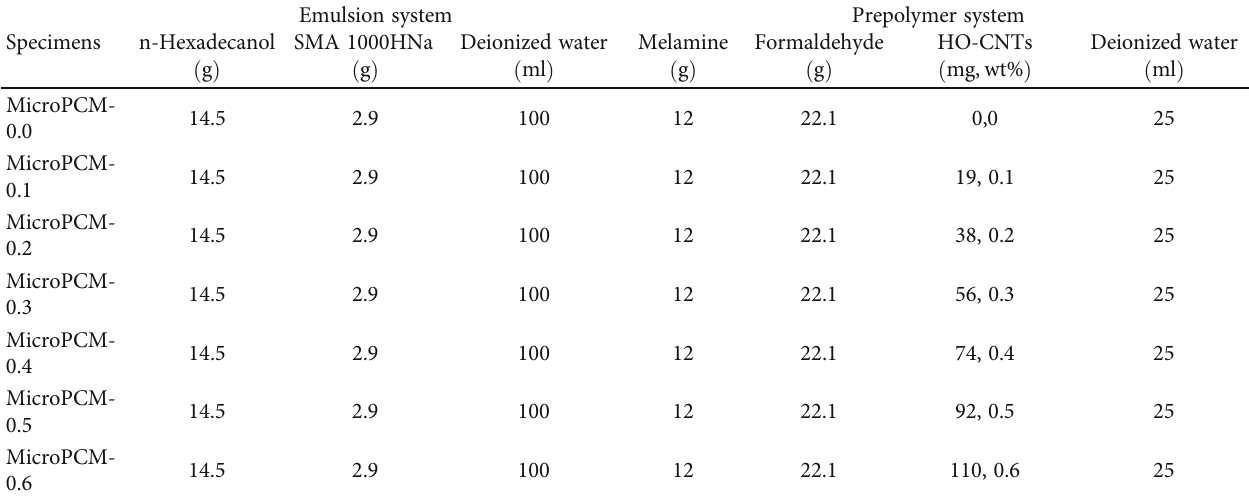
Table 1: The experimental protocol for the fabrication of hydroxylated CNTs improved micro-phase-change